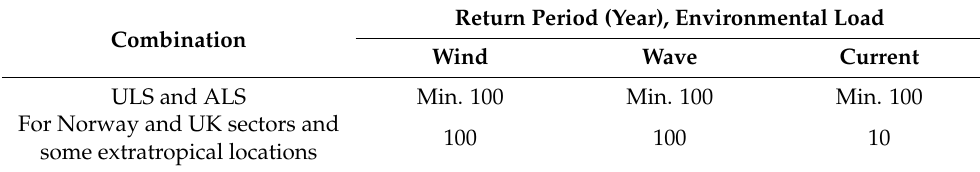
Table 10. Combination of environmental loads considered for ULS and ALS from